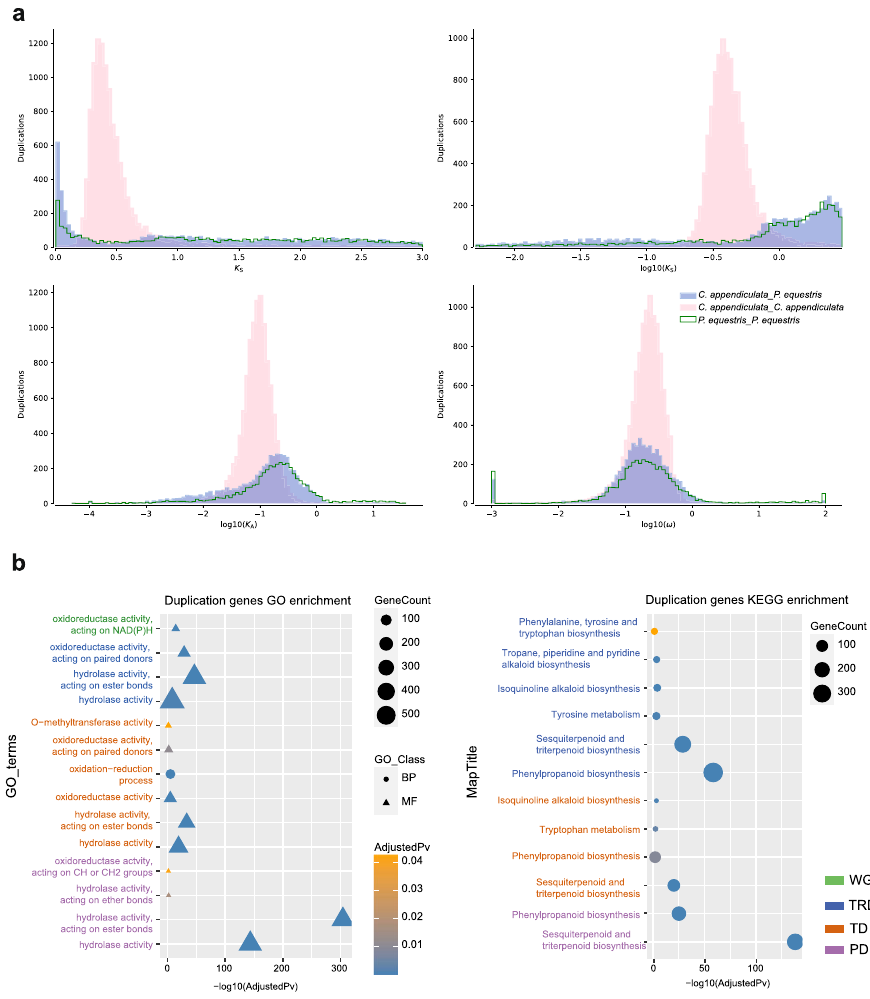
Fig. 3 The analysis of C. appendiculata WGD event. a The distribution of synonymous substitution rate ( K s ) distance values observed for C. appendiculata paralogs, P. equestris paralogs, and C. appendiculata – P. equestris orthologs, respectively. b The GO and KEGG function enrichment analysis of different duplication genes: genome duplication (WGD), tandem duplication (TD), proximal duplication (PD), and transposed duplication